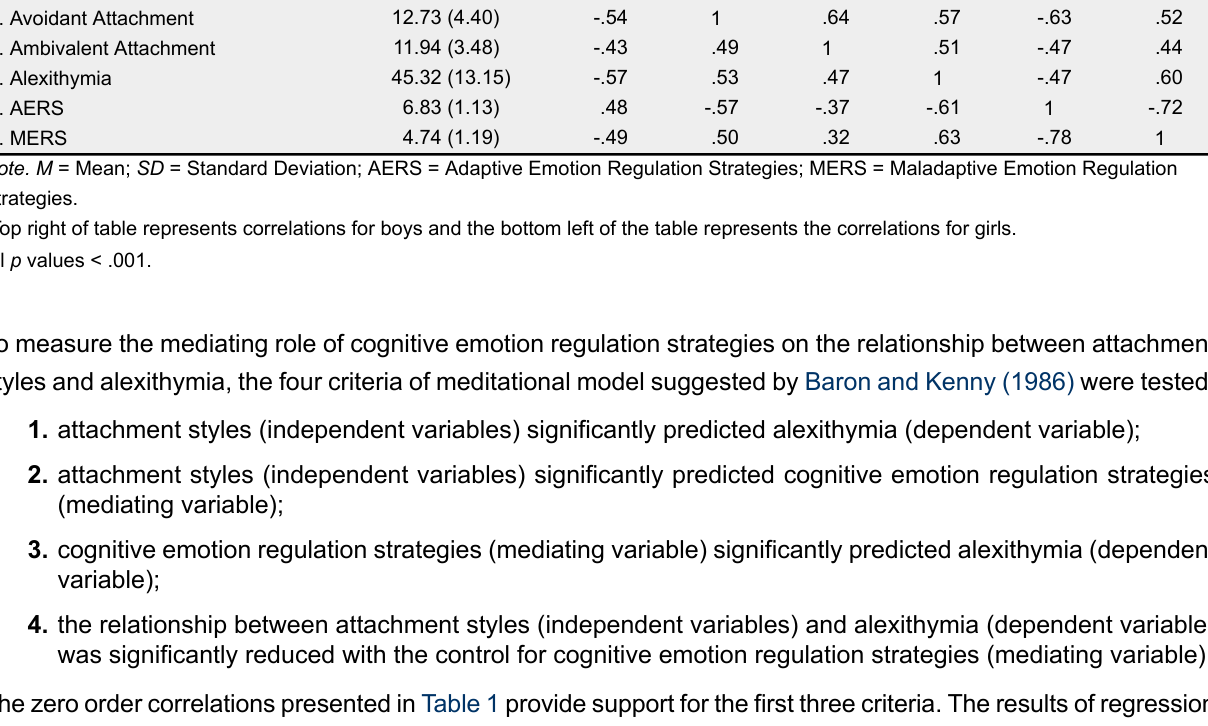
Mean Scores, Standard Deviations, and Zero Order Correlations Between Study Variables